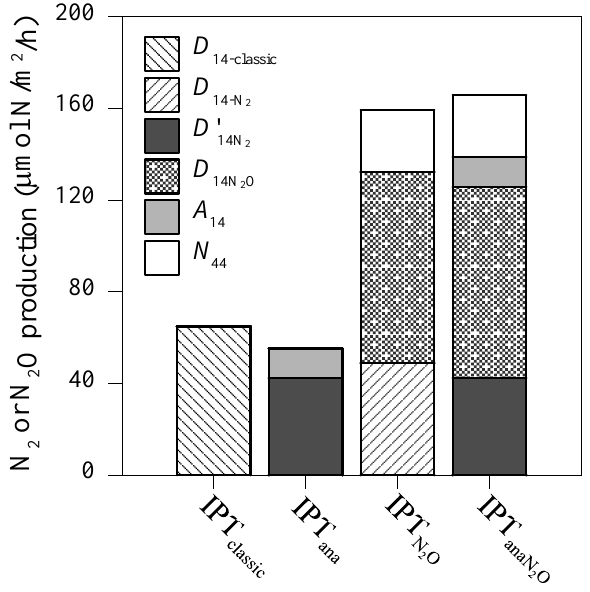
Fig. 4. Comparison of N 2 or N 2 O production rates estimated by Figure 4. Comparison of N 2 or N 2 O production rates estimated by different versions 921 different versions of of IPT. 922